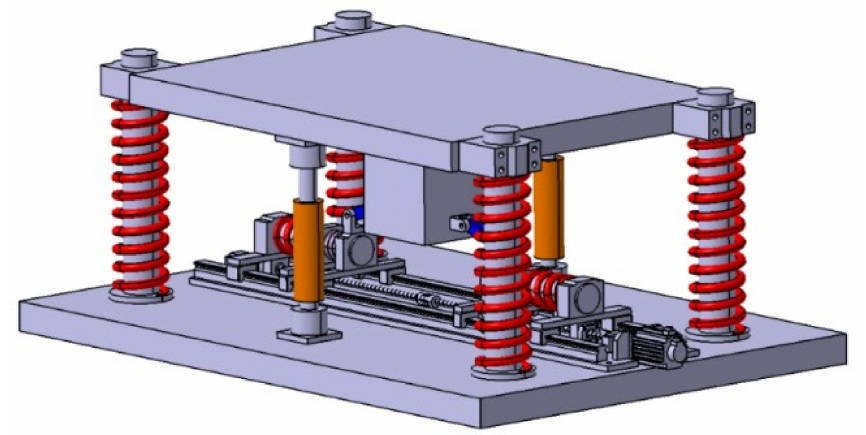
Figure 12. The prototype of the active vibration control mechanism with